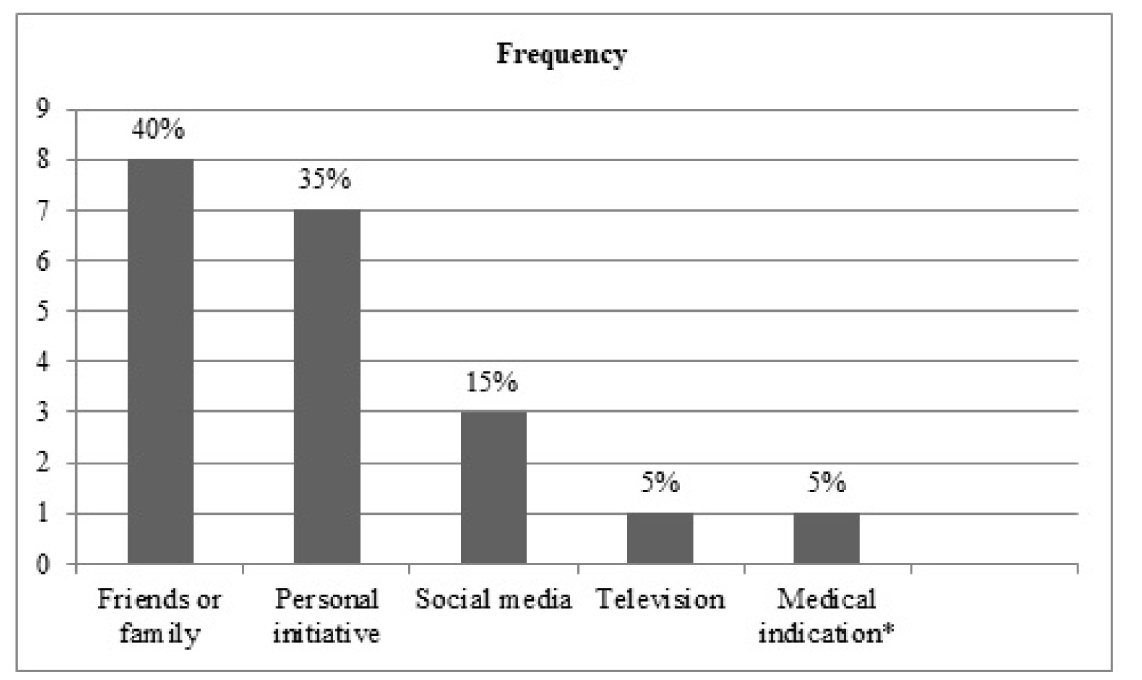
Figure 1 - Approach reason Source: study